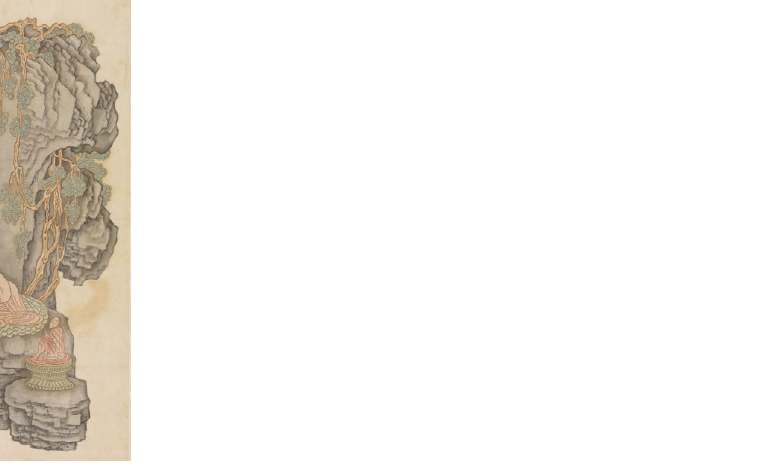
Figure 3. Wu Bin, “Upaniṣad” from Twenty‑five Dharma Gateways of Perfect Wisdom , ca. 1600. Album leaf, ink and color on silk, 62.3 × 35.3 cm. Photo: Courtesy of National Palace Museum,